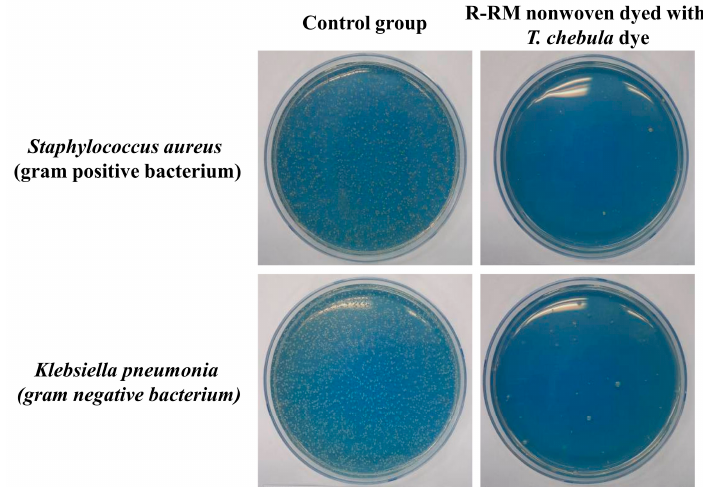
Figure 11. Images of the antibacterial test of the R-RM nonwoven dyed with T. chebula dye. Table 5. Antibacterial ability of the R-RM nonwoven dyed with T. chebula dye according to bacteria strains.